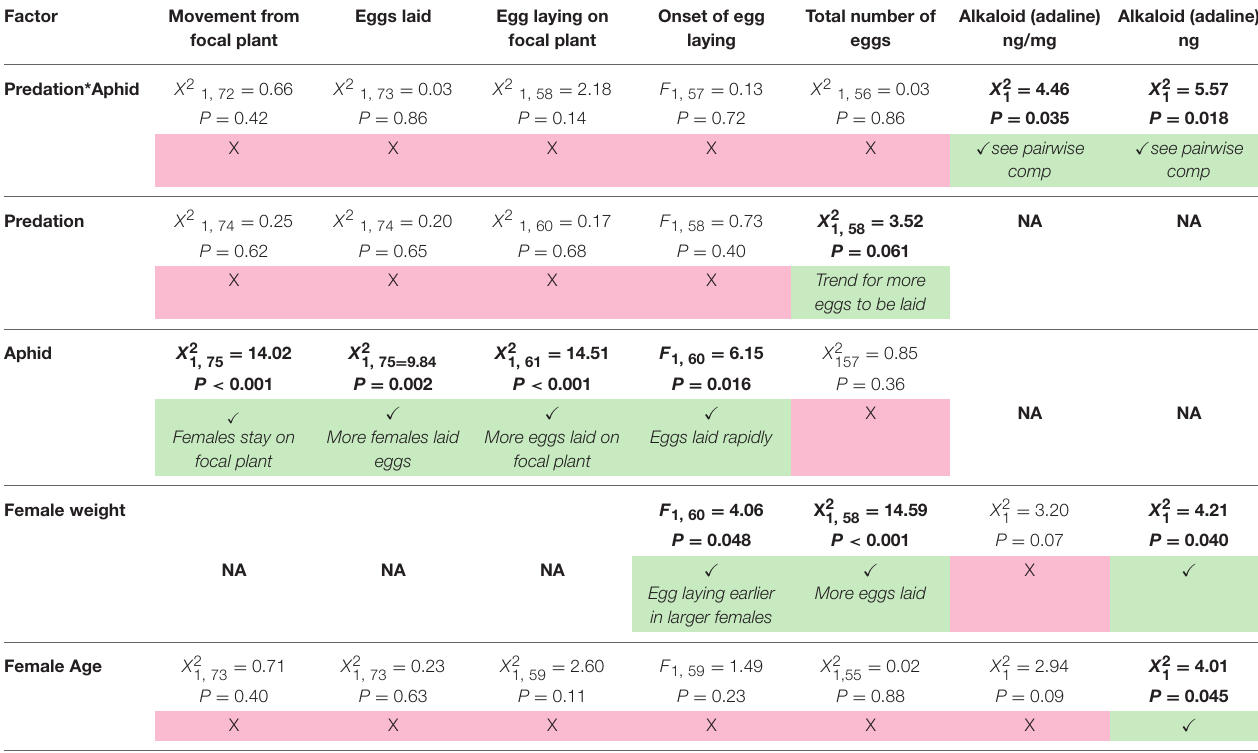
TABLE 1 | Summary of the results of the effect of predation risk, aphid presence, the interactive effect of predation risk and aphid presence, and the effect of female age on the movement and egg laying behavior of female ladybirds during the experiment. Factor Movement from Eggs laid Egg laying on Onset of egg Total number of Alkaloid (adaline) Alkaloid (adaline) focal plant focal plant laying eggs ng/mg ng Predation*Aphid